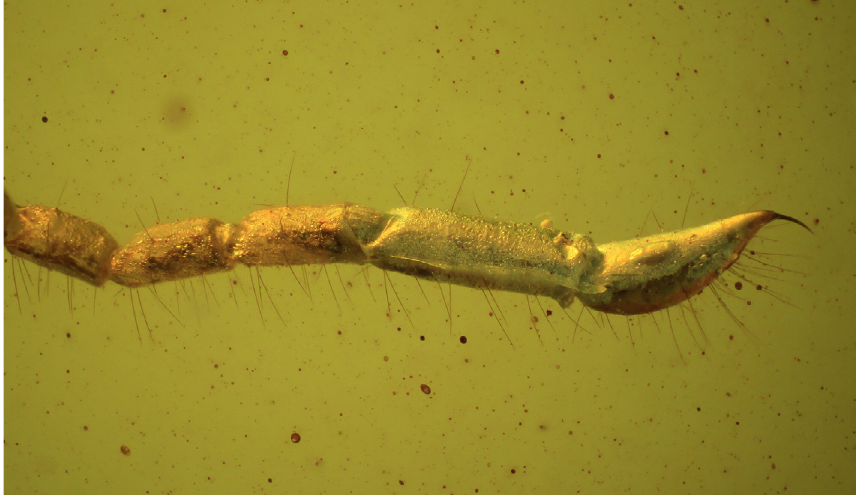
Figure 8. Bulbous telson with a short aculeus in the Cretaceous amber protoischnurid Cretaceoushormiops knodeli